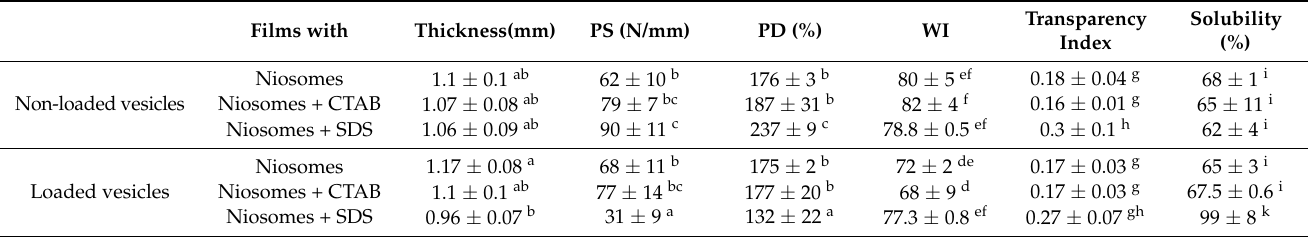
Table 4. Physical properties of each film with vesicles loaded vanillin and non-loaded niosomes. Films with